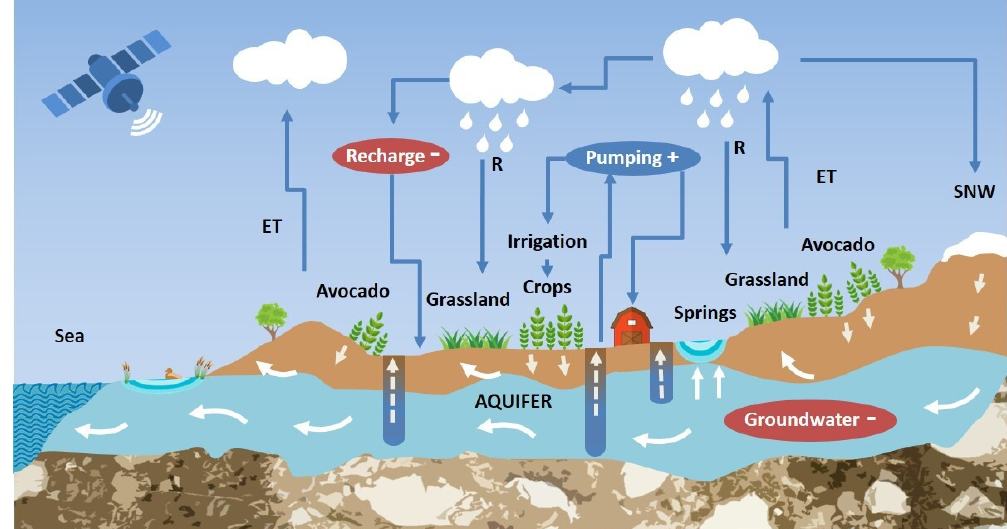
Figure 1. Conceptual diagram of the relationship among groundwater (GW), agriculture, and rainfall in the study area. ET—evapotranspiration, R—rainfall, and SNW—snow.